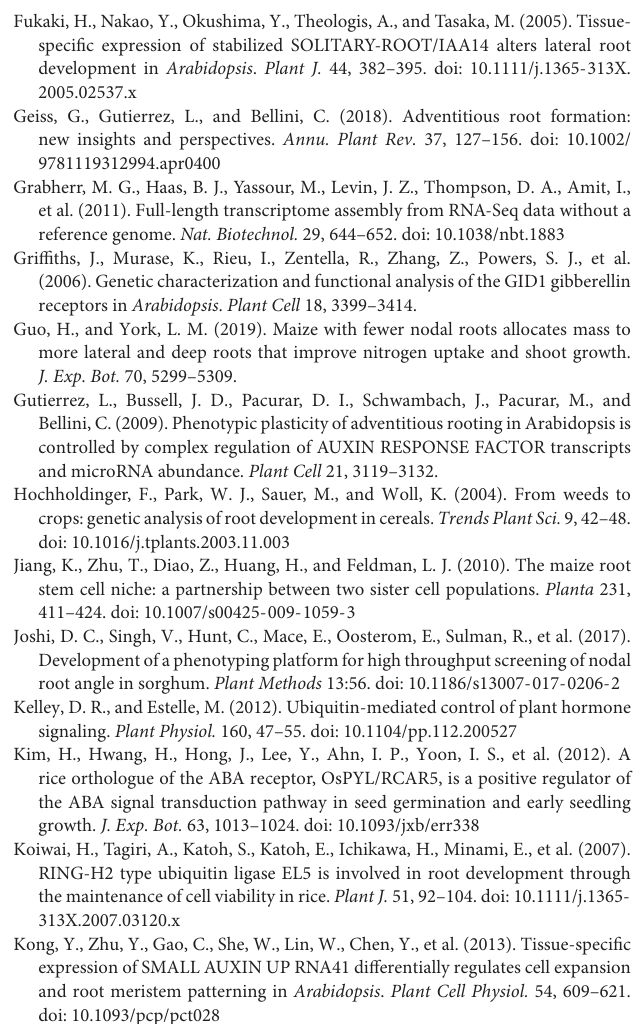
Supplementary Figure 3 | Trend analysis of DEGs in “Plant hormone signal transduction,” “E3 ubiquitin-protein ligase,” and “Transcription factor.” The color modules are significantly enriched modules with p < 0.05. The same color indicates a similar trend. Supplementary Figure 4 | qRT-PCR validation of 12 genes randomly selected from the 109 DEGs in Supplementary Table 1 . Values are presented as the mean ± SE. The column diagrams represent the relative expression levels of genes. The line charts represent the FPKM values of genes. Supplementary Figure 5 | Gene structure and protein alignment of EoSINAT5 . (A) Structural analysis of the EoSINAT5 gene in Arabidopsis and centipedegrass. Black boxes represent exons, and black lines represent introns. (B) Protein alignment of SINAT5s from Sorghum bicolor (SbSINAT5, XP_002461156.1), Setaria italica (SiSINAT5, XP_004958578.1), Dichanthelium oligosanthes (DoSINAT5, OEL30966.1), Oryza sativa japonica group (OsSINAT5, indicates a conserved Sina region of SINAT5 proteins. Black, red, and blue